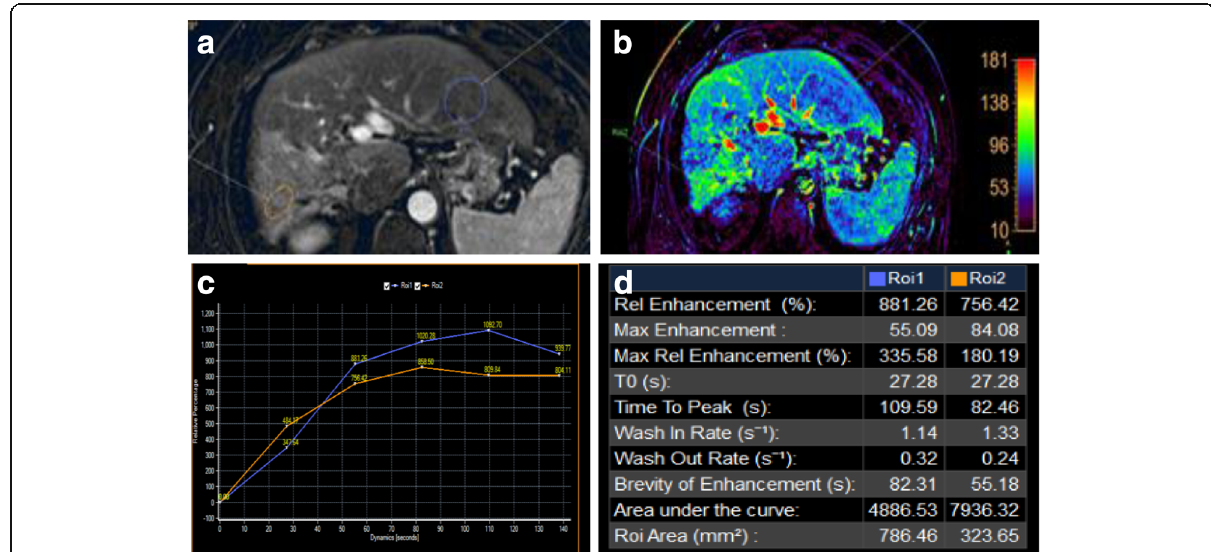
Fig. 11 Hepatic focal lesion after TARE. a Subtracted enhanced T1-WI in the arterial phase shows faint enhancement of the treated right lobe (ROI 2 “ orange ” ) compared to untreated hepatic parenchyma (ROI 1 “ blue ” ). b T1 perfusion map (max. relative enhancement) shows mild increased blood flow to the treated right lobe. c Time-intensity curves on the treated right lobe (orange) and untreated left lobe (blue) show an uprising slope and followed by a plateau for the lesion due to fibrosis. d Semi-quantitative data for both ROIs show decreased max. relative enhancement, time to peak, wash in rate, and wash out rate of the treated hepatic parenchyma compared to the rest of the hepatic parenchyma. Final diagnosis is LR-TR nonviable with post-therapy changes